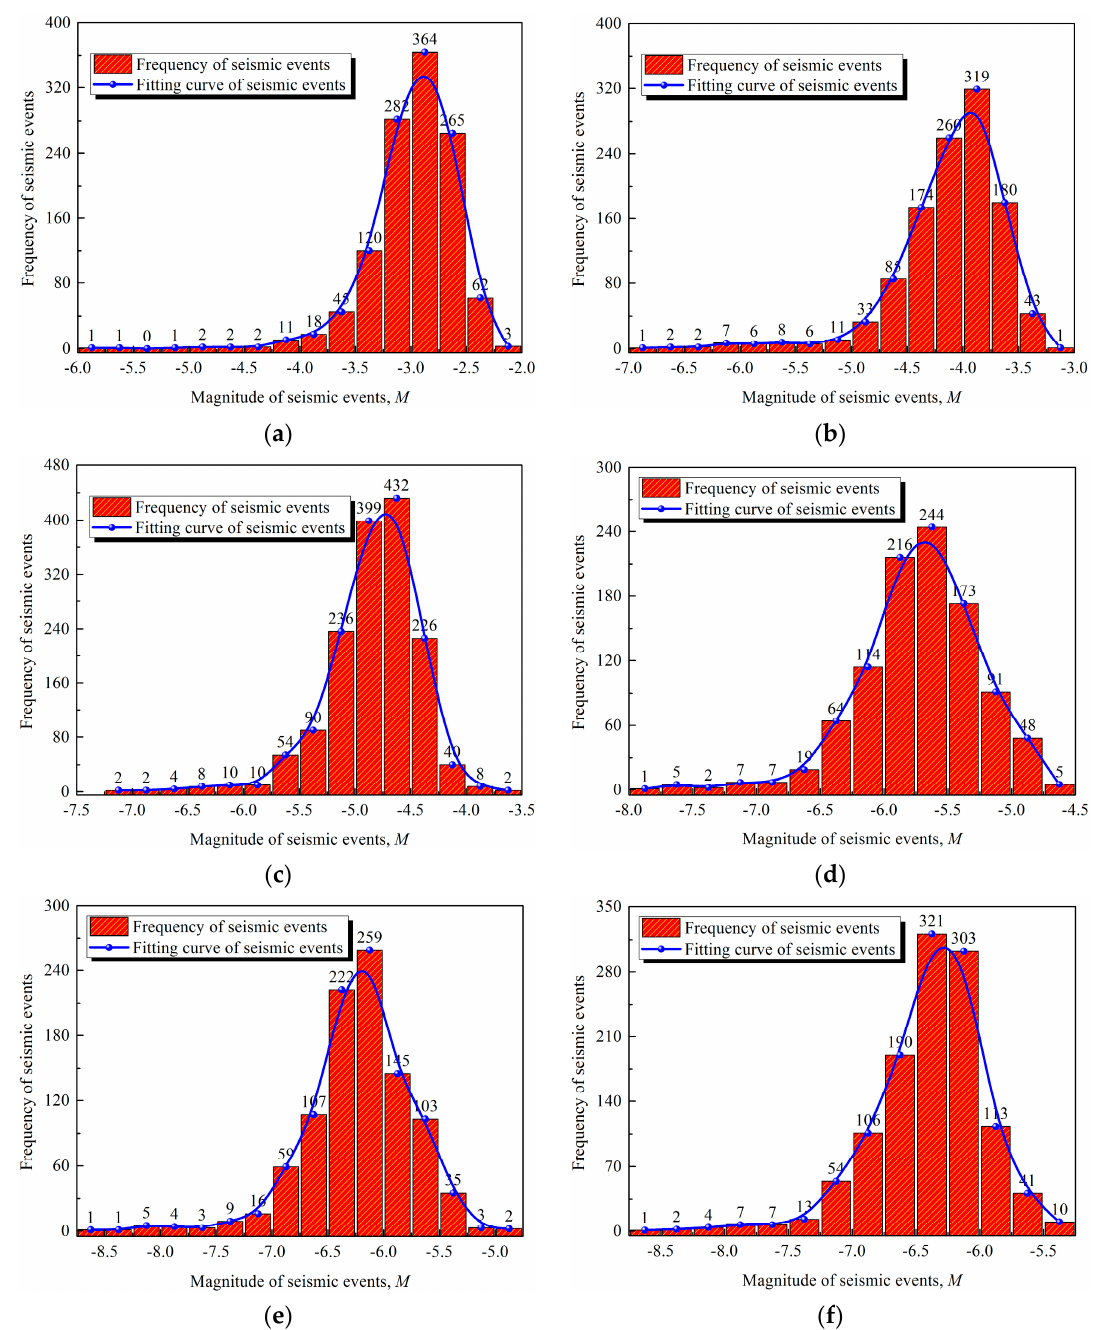
Figure 18. Relationship between the magnitude of seismic events and the frequency of seismic events with different injection sites: ( a ) L if = 10 m; ( b ) L if = 20 m; ( c ) L if = 30 m; ( d ) L if = 40 m; ( e ) L if = 50 m; and ( f ) L if = 60 m.